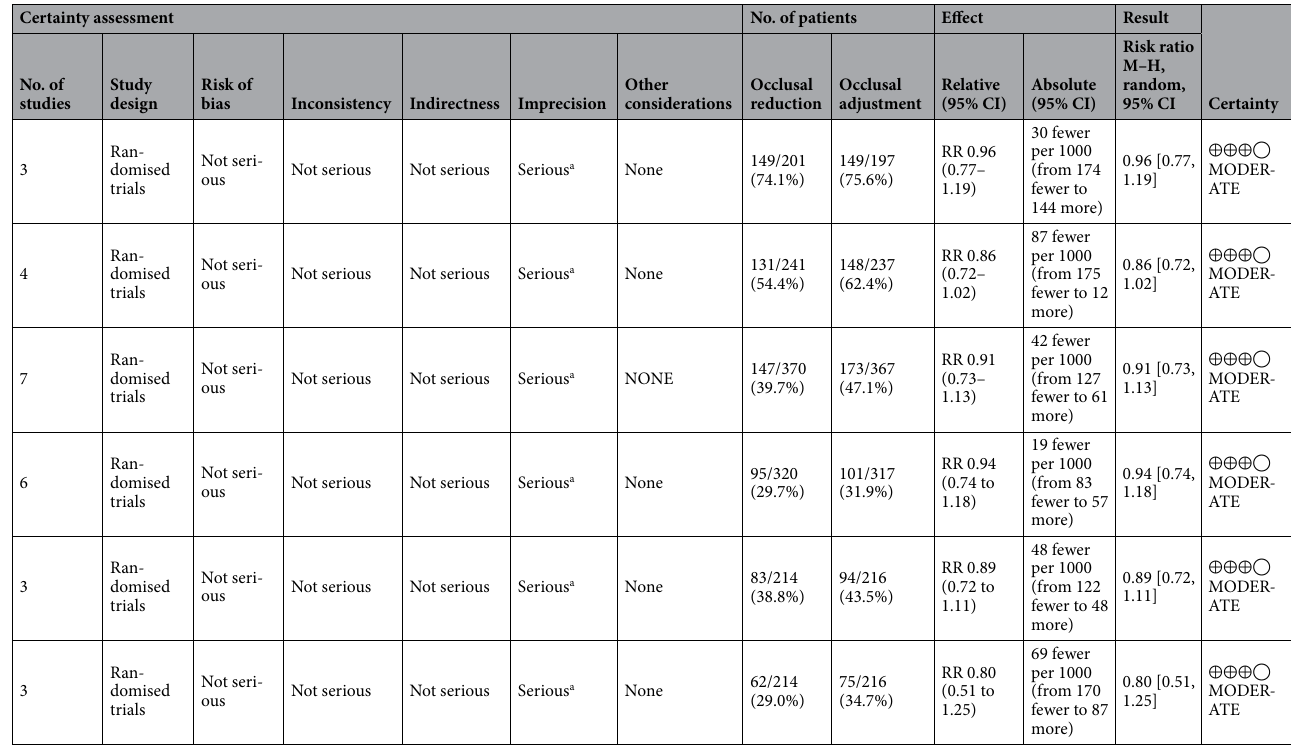
Table 3. Grade of Recommendation, Assessment, Development, and Evaluation (GRADE) based on the characteristics of studies included in the systematic review and meta-analysis. GRADE approach results in an assessment of the quality of a body of evidence High: Very confident that the true effect lies close to that of the estimate of the effect. Moderate: Moderately confident in the effect estimate, the true effect is likely to be close to the estimate of the effect, but there is a possibility that it is substantially different. Low: Limited confidence in the effect estimate, the true effect may be substantially different from the estimate of the effect. Very low: Little confidence in the effect estimate, the true effect is likely to be substantially different from the estimate of effect. a The confidence interval (CI) cross the clinical decision threshold between recommending and